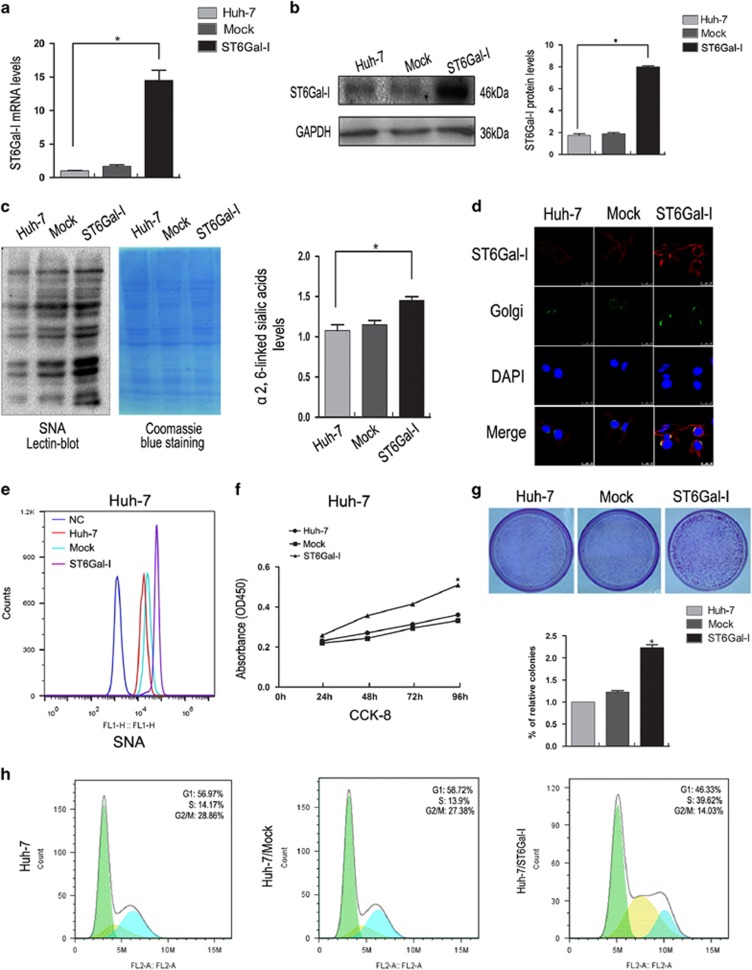
Overexpression of ST6Gal-I contributes to proliferation and metastasis in Huh-7 cells in vitro. (a, b, d) Analysis of ST6Gal-I expression in Huh-7 cell transfected with pcDNA3.1/ST6Gal-I by qPCR (a), western blotting (b) and immunofluorescence (d). (c, e) α2, 6-linked sialic acid expression levels determined by lectin blotting and flow cytometry. (f) ST6Gal-I overexpression enhances the viability of Huh-7 cells as indicated by CCK-8 assay. (g) Colony formation assay was used to evaluate the proliferation of Huh-7 cells after stimulating the expression of ST6Gal-I. (h) Cell cycle distribution analysis by FACS showed that the rate of S phase was higher in Huh-7/ST6Gal-I cells than in the control group. (i) Migration behaviors of Huh-7 cells with upregulated ST6Gal-I expression explored by a wound-healing assay. (j, k) Transwell assays showed that overexpression of ST6Gal-I increases the invasion and migration rates of Huh-7 cells. All quantitative data are shown as the mean±s.d. of three independent experiments. *P<0.05.